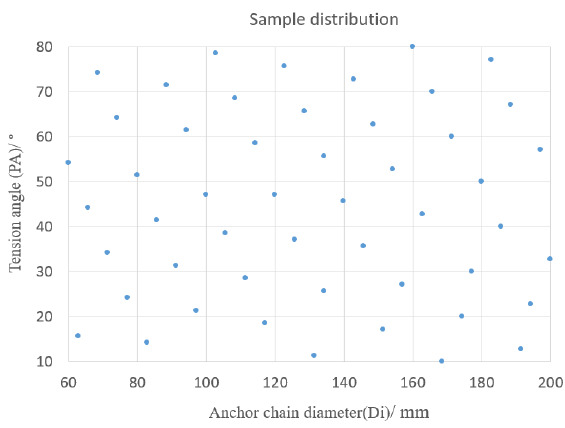
Figure 6. Sampling point distribution of design variables.